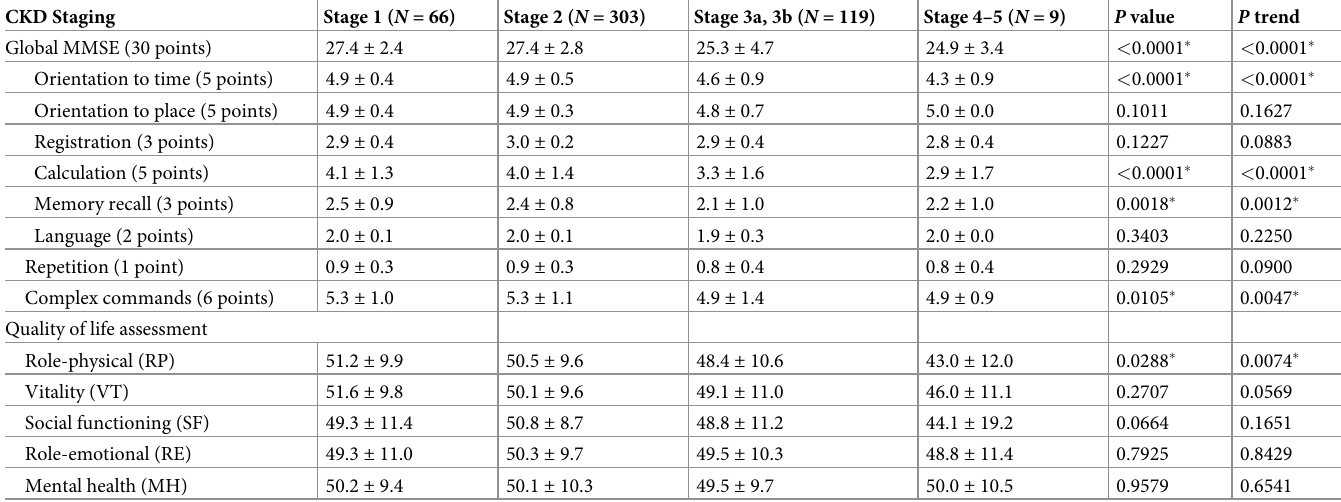
Table 2. Mini-Mental State examination and quality of life assessment of all participants ( N =